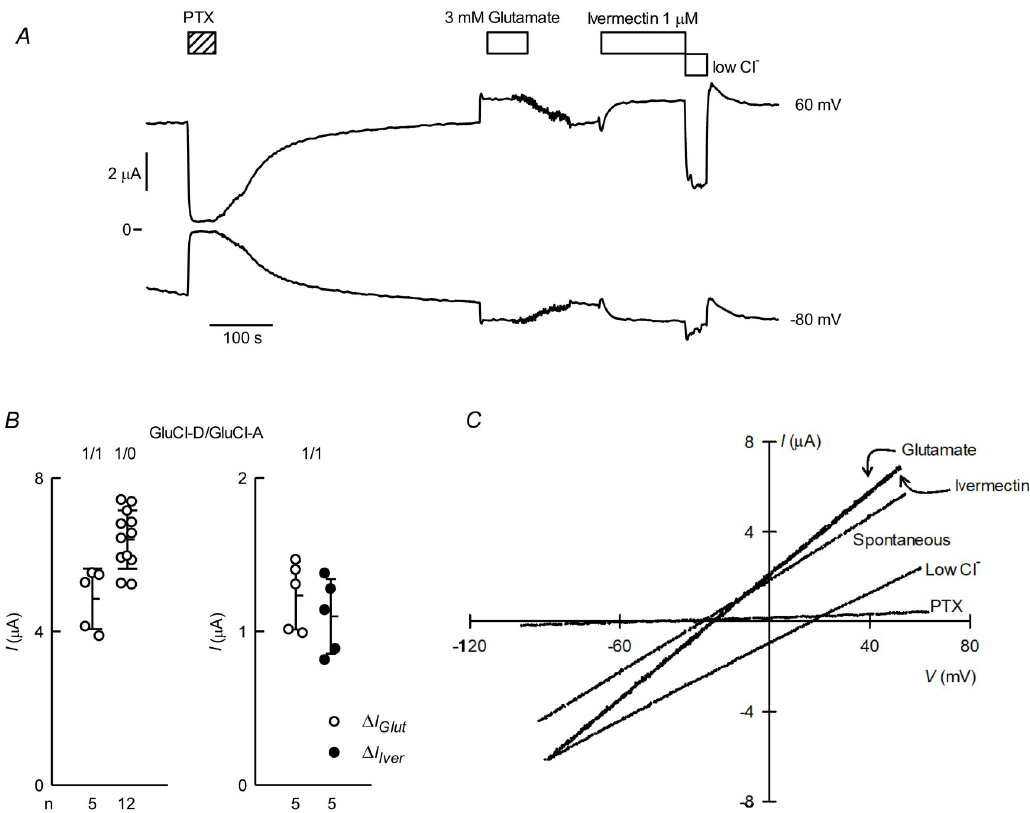
Fig 12. Currents in Xenopus oocytes microinjected with CrGluCl-D and CrGluCl-A cRNAs. A. Spontaneous currents in an oocyte expressing subunits D and A after microinjection of 10ng cRNA for each CrGluCl-D and CrGluCl-A. The effects of 3 mM glutamate or 1 μ M ivermectin, as well as that of partial chloride removal are also shown. Recording shown were taken at 60 mV and -80 mV. B. Summary of spontaneous currents for the mixed D:A subunit expressions compared with those for the D subunit on its own. On the right hand panel are data for the extra current elicited by glutamate or ivermectin in oocytes expressing CrGluCl-D and CrGluCl-A. Total cRNA injected was always 20 ng. Data points report individual measurements with means ± SDs also shown, n indicated under the abscissa. C. IV relations corresponding to the spontaneous currents before any addition, during the glutamate or ivermectin challenges, after partial chloride removal or PTX inhibition.